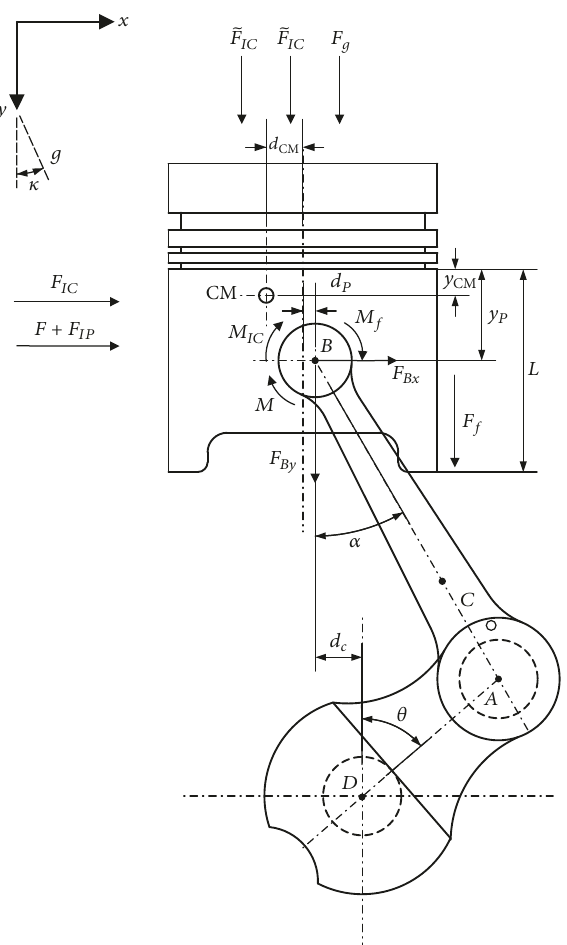
Figure 1: Geometrical model of piston-connecting rod